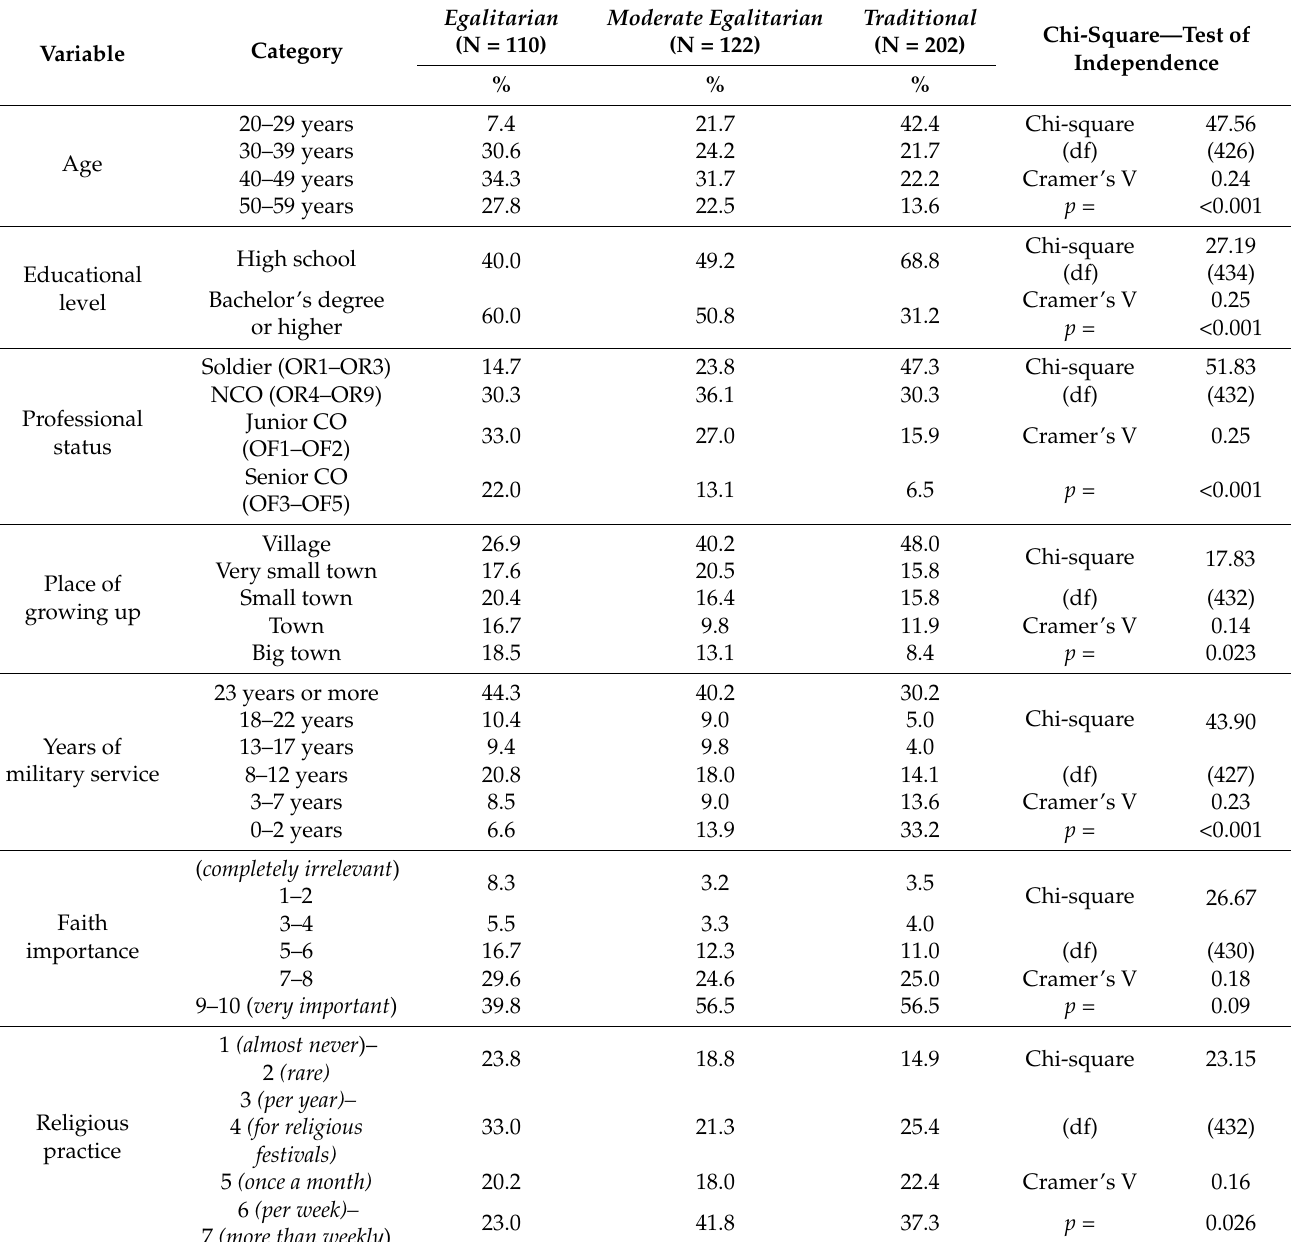
Table 9. Differences in women’s sexism endorsement types according to personal